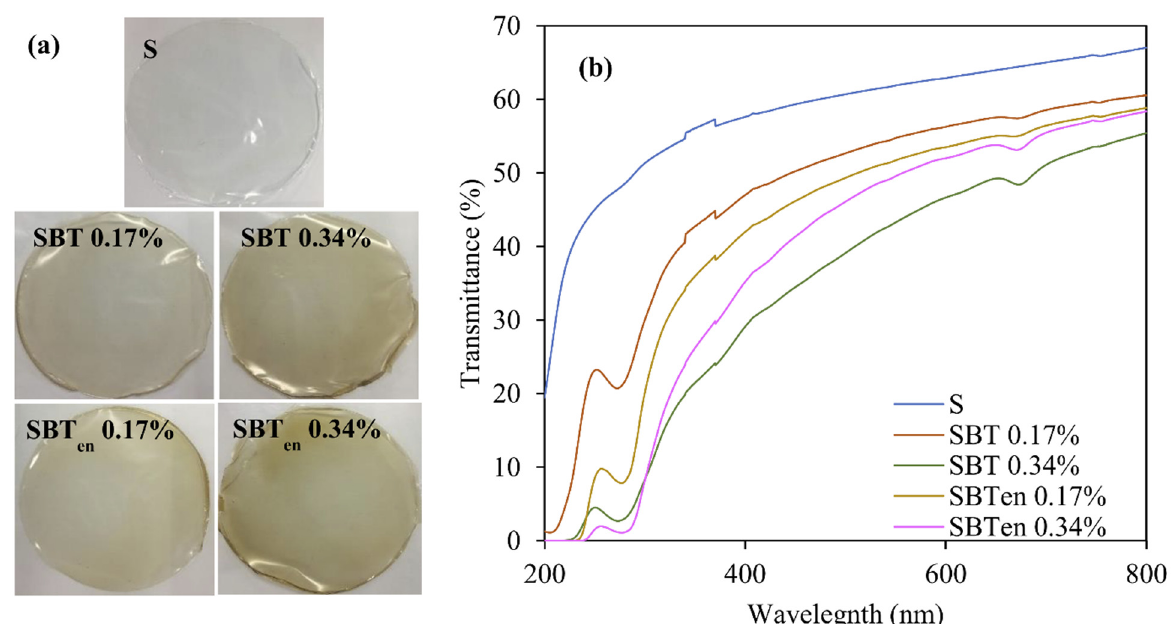
Figure 4. The visual appearance ( a ) and light transmittance ( b ) of the control film (S) and starch films incorporating free or encapsulated SBT extracts at 0.17% or 0.34%.